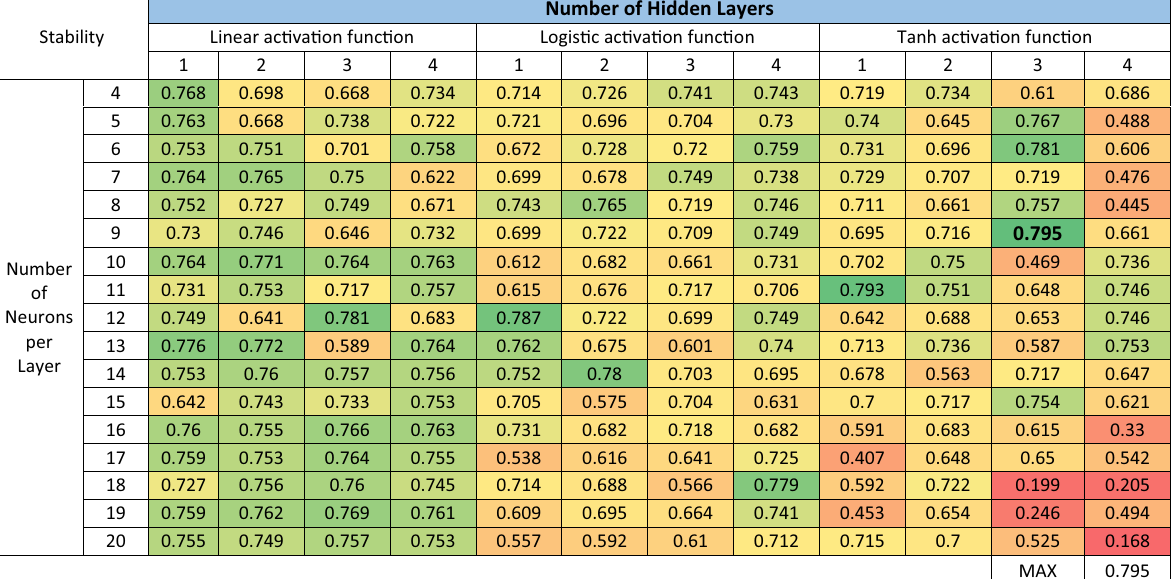
Number of Hidden